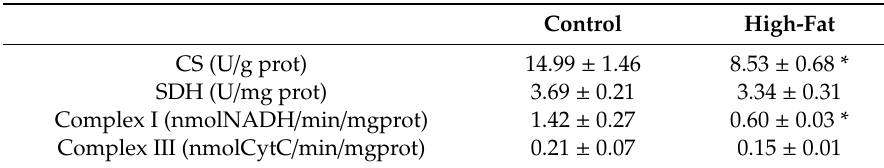
All data are presented as means ± standard error of the mean (SEM, n = 6). The asterisk indicates significant di ff erence ( P < 0.05, Student’s t-test). SDH, succinate dehydrogenase; CS, citrate synthase. Complex, mitochondrial respiratory chain